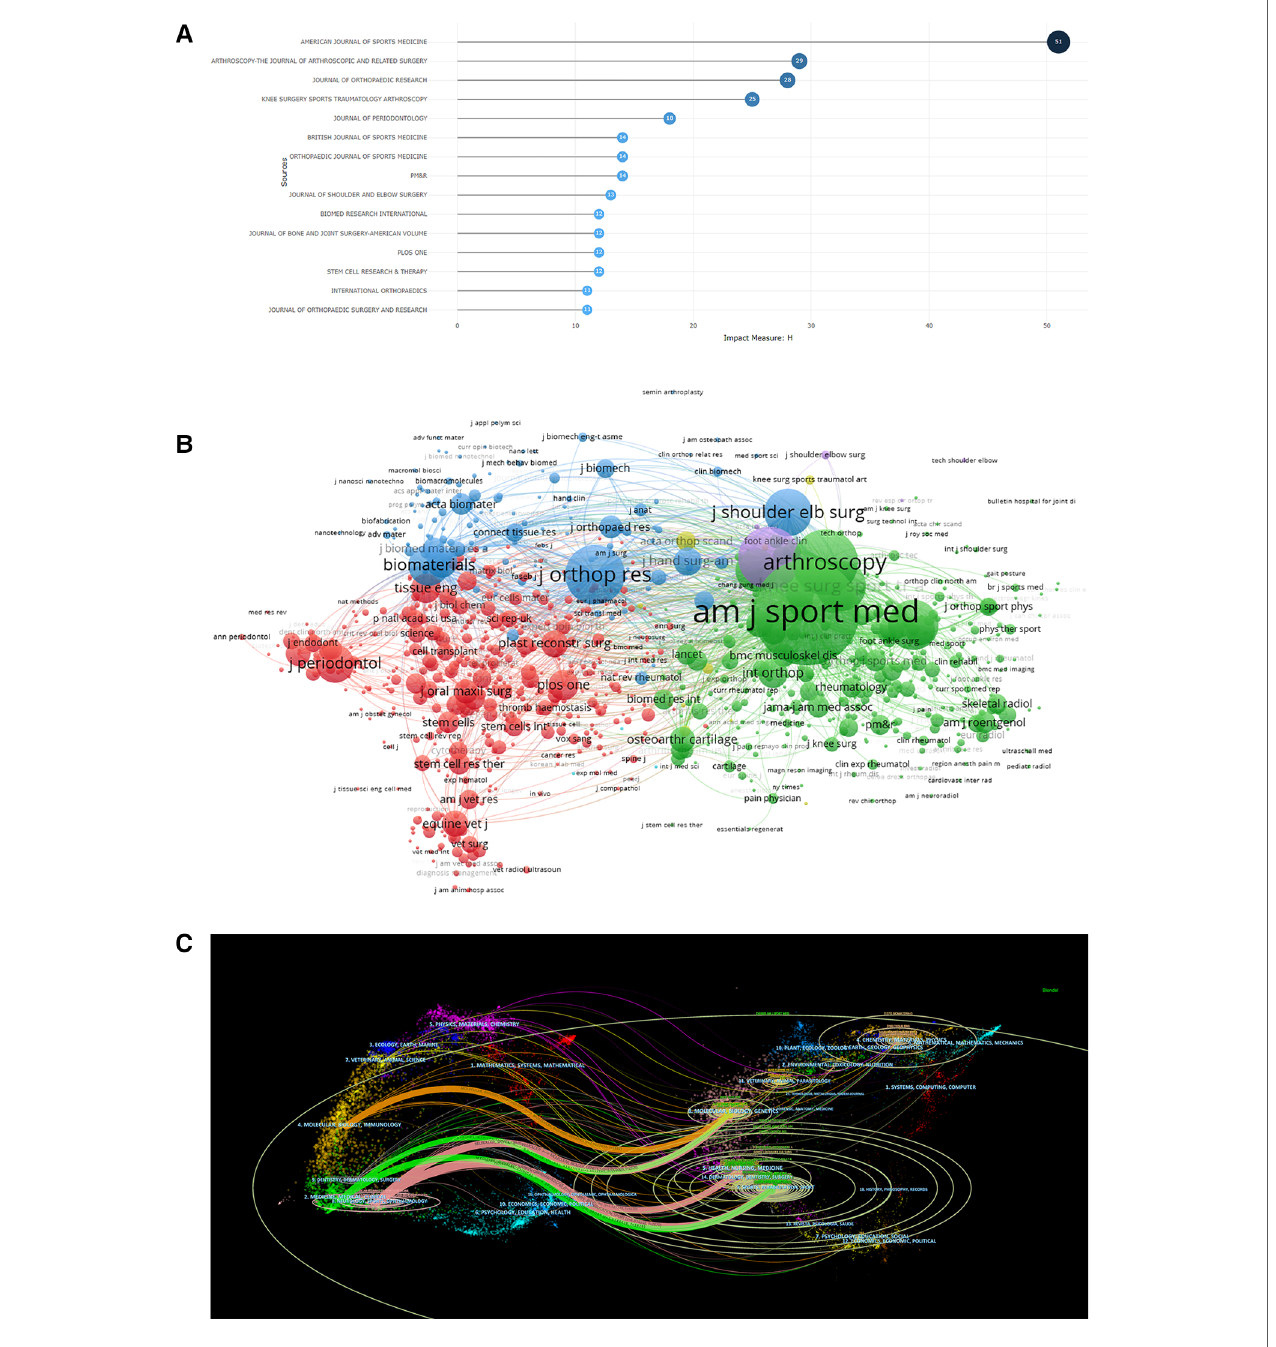
FIGURE 4 ( A ) H-index of high-impact journals for platelet-rich plasma for tendon and ligament injury research, 2003-2022. ( B ) Cluster visualization of journal co-citation analysis generated based on VOSviewer software. Note: Each node represents a journal, and the size of each circle is determined by the journal ’ s co-citation. ( C ) Double graph overlay of cited and cited journals in the fi eld of platelet rich plasma for tendon and ligament injury research. Note: Cited journals are on the left, cited journals are on the right, and the line represents the citation